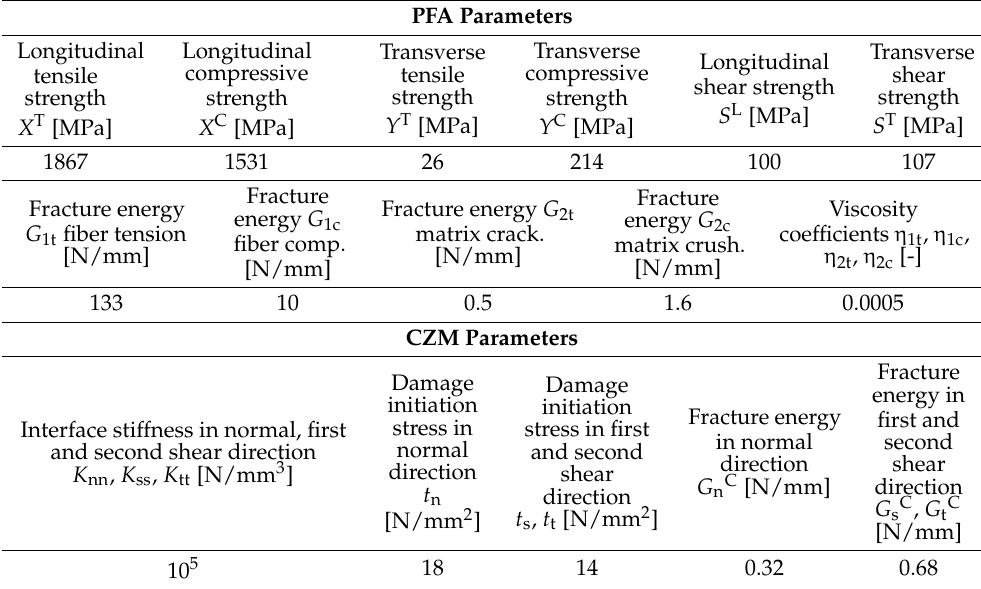
Table 2. Progressive failure analysis (PFA) and cohesive zone model (CZM) parameters. PFA